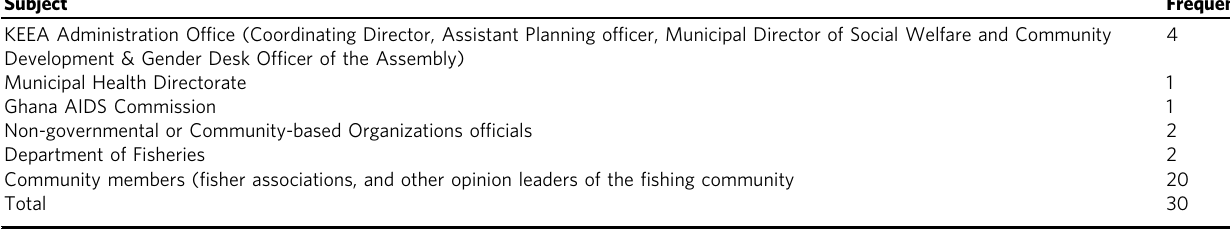
Table 1 Participants of the Key Informant